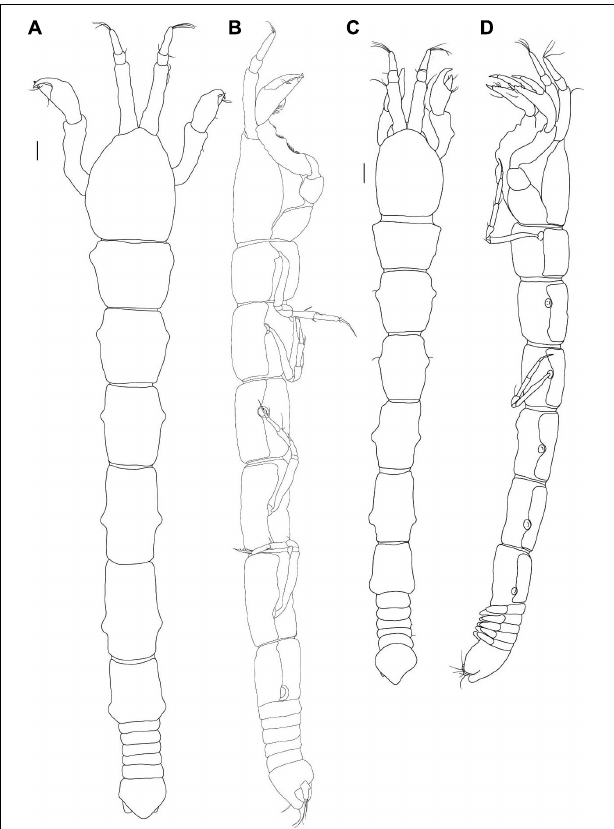
FIGURE 9 | Agathotanais jani n. sp., neuter, paratype (ZMH-K-61150). (A) antennule and antenna; (B) labrum; (C) left mandible; (D) right mandible; (E) maxillule; (E’) details of maxillule; (F) maxilla; (G) labium; (H) maxilliped. Scale bar: (A–H) = 10 µ